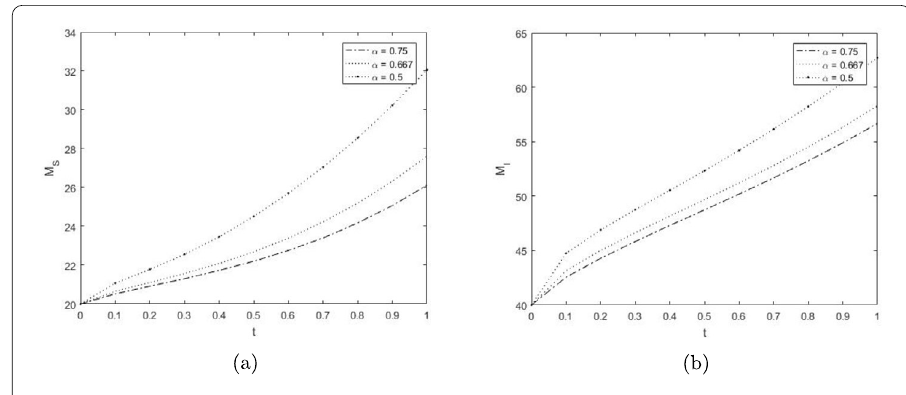
Figure 2 Variation of M S , M I versus t for α = 0.75,0.667,0.50